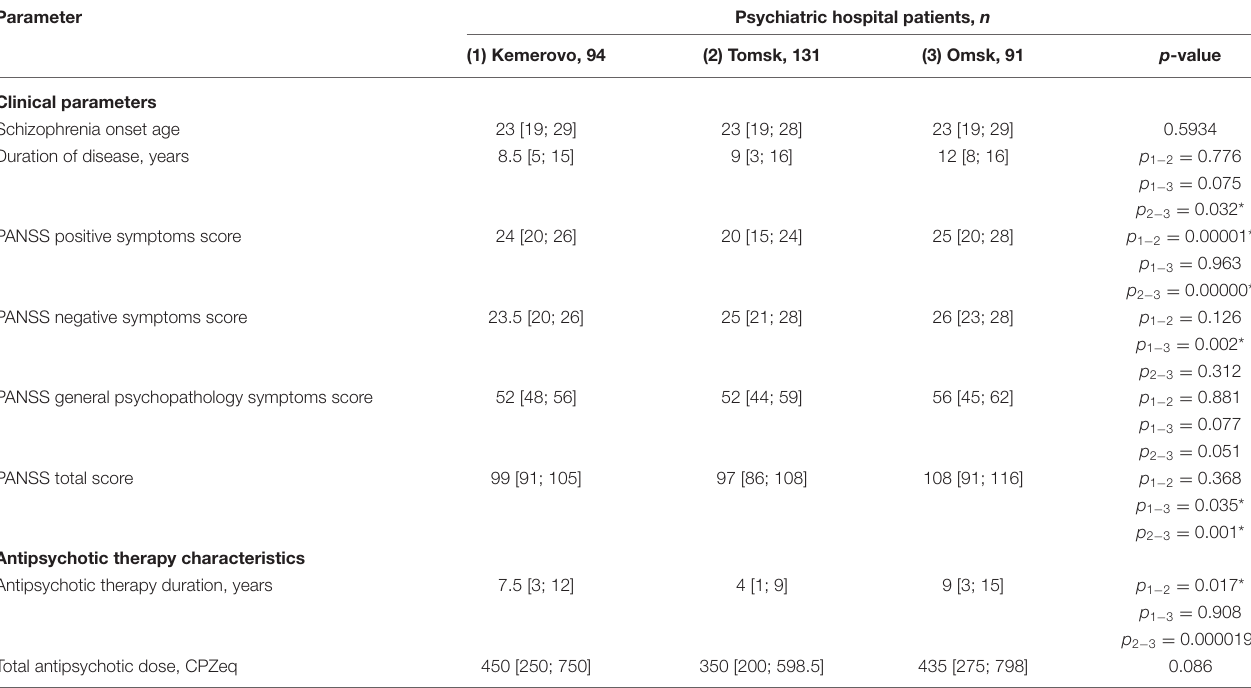
TABLE 3 | Comparative characteristics and evaluation of clinical parameters and antipsychotic therapy in the study population (Me [Q1; Q3]). Parameter